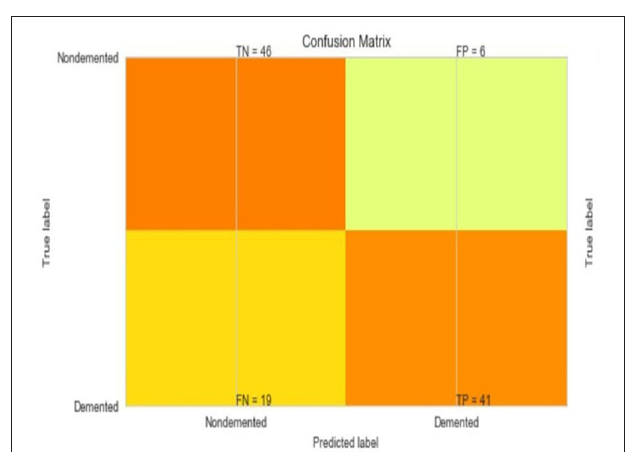
FIGURE 13 | Confusion matrix for hard voting classifier.